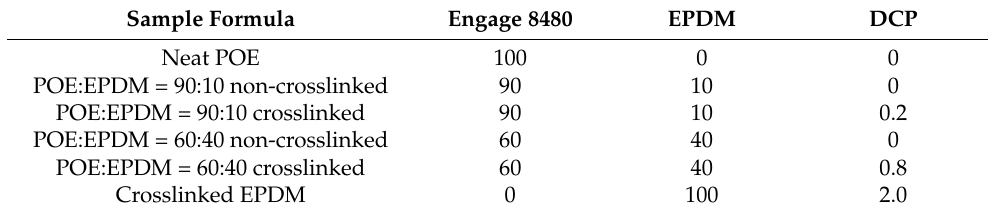
Table 1. The formulas of neat POE, crosslinked EPDM, and POE /EPDM blends. Sample